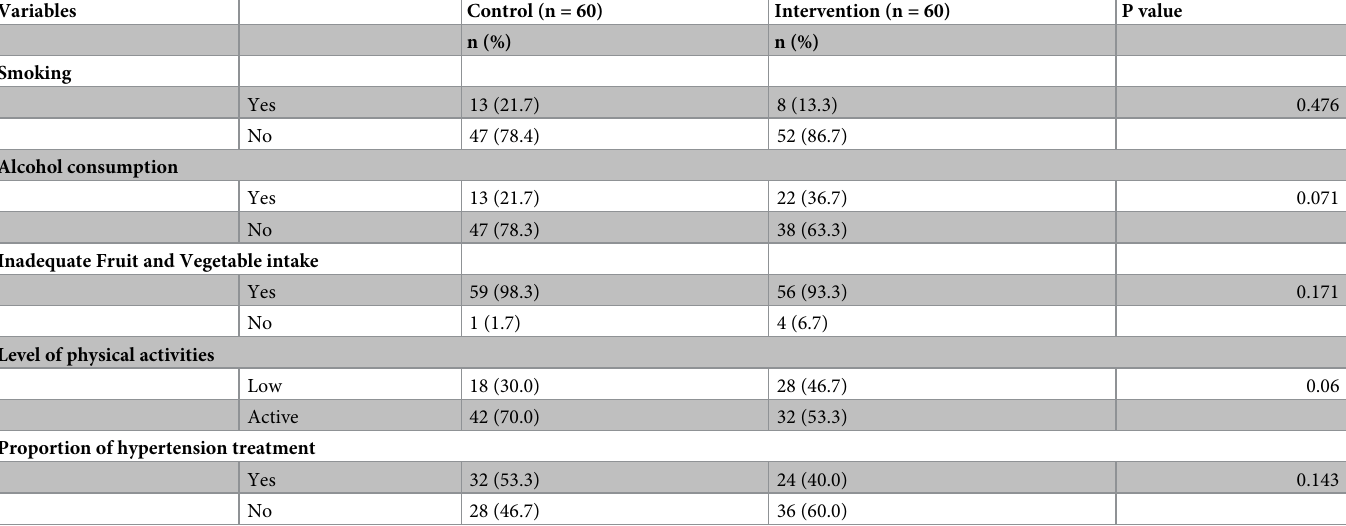
Table 2. Baseline smoking, alcohol consumption, fruit and vegetable intake, physical activities and drug intake.